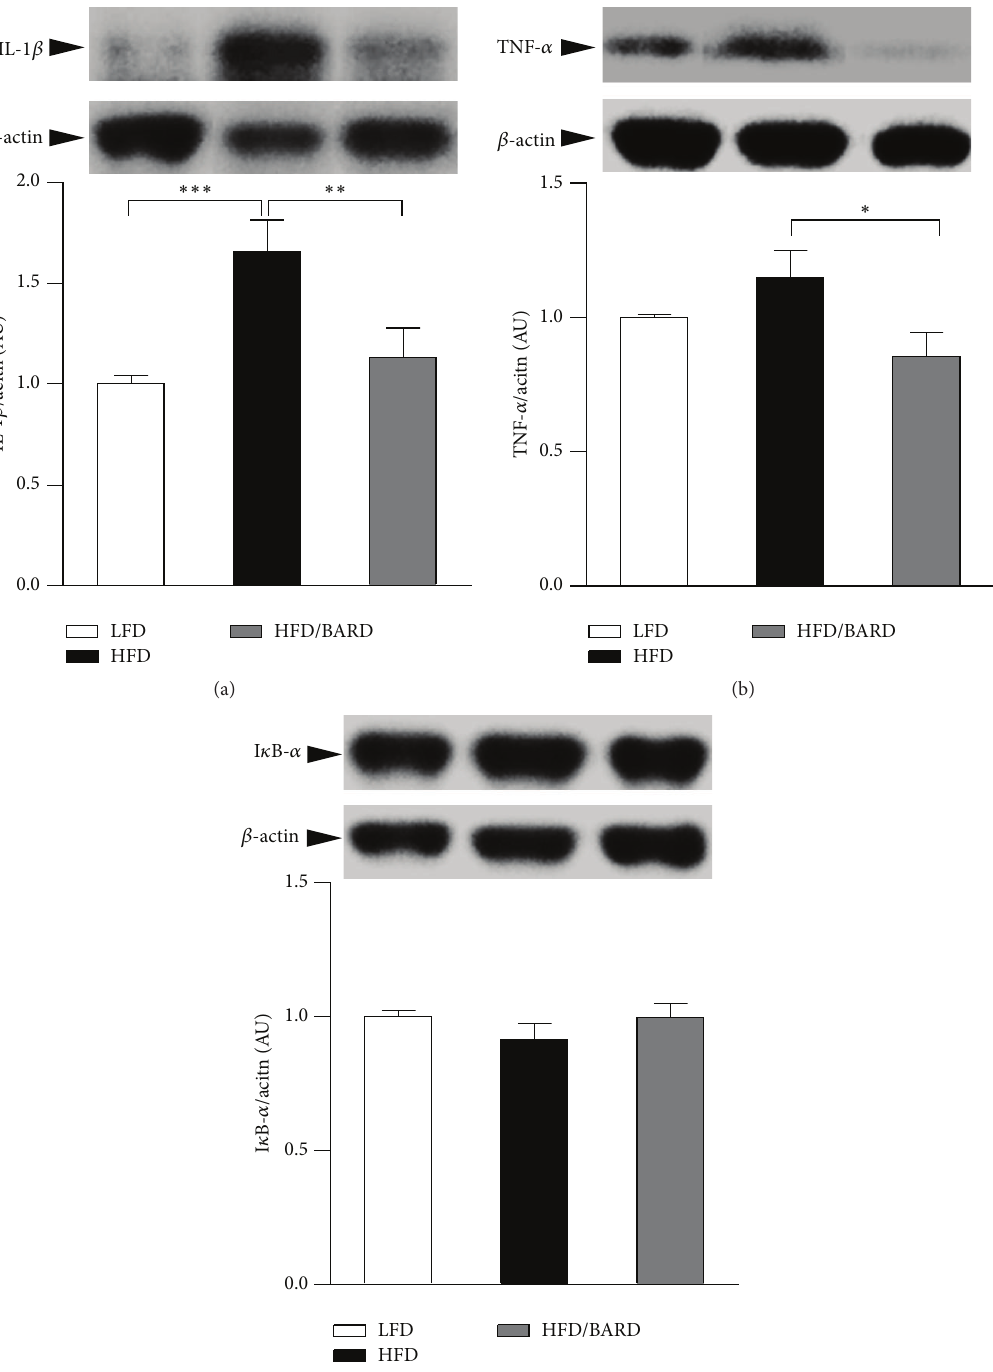
Figure 3: Effect of bardoxolone methyl (BARD) on expression of proinflammatory cytokines in mesenteric adipose tissue of mice fed low- fat diet (LFD), high-fat diet (HFD), and high-fat diet supplemented with BARD (HFD/BARD). (a) Representative blots and protein level of IL-1 𝛽 . (b) Representative blots and protein level of TNF- 𝛼 . (c) Representative blots and protein level of I 𝜅 B- 𝛼 . All data are presented as mean ± SEM. ∗ 𝑝 < 0.05 ; ∗∗ 𝑝 < 0.01 ; ∗∗∗ 𝑝 < 0.001 . IL-1 𝛽 : interleukin-1 beta, TNF- 𝛼 : tumour necrosis factor alpha, I 𝜅 B- 𝛼 : nuclear factor of kappa light polypeptide gene enhancer in B-cells inhibitor alpha, and AU: arbitrary